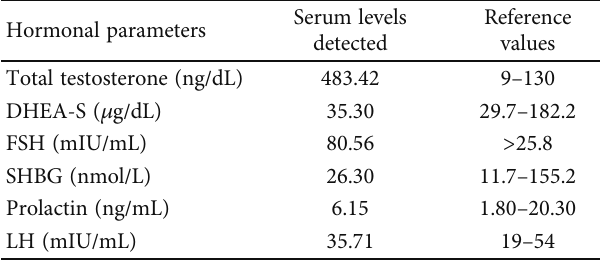
DHEA-S: dehydroepiandrosterone sulfate; FSH: follicle-stimulating hormone; SHBG: sex hormone binding globulin; LH: luteinizing